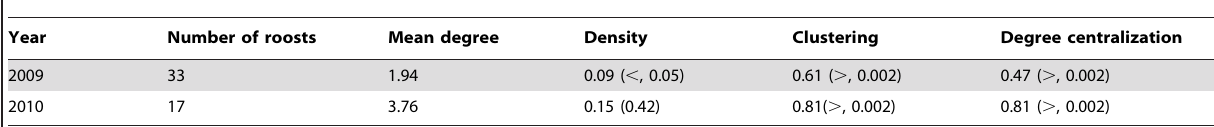
Table 1. Indiana bat ( Myotis sodalis ) roost network metrics.